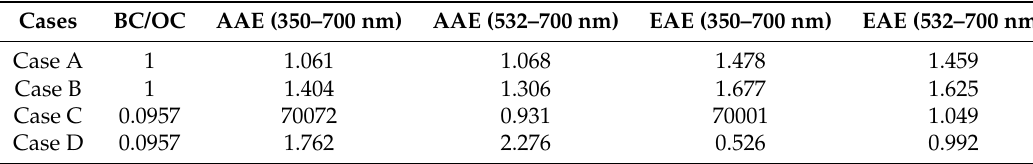
Figure 9. AAE and EAE of BC at different wavelength pairs for different mixing states and size distributions, σ g = 1.5.BC/OC = 0.1 for thinly-coated BC and BC/OC = 0.096 for heavily-coated BC. Table 2. Spectral-dependent characteristics of the modeled BC under different mixing states, r g = 0.06 µ m , σ g =